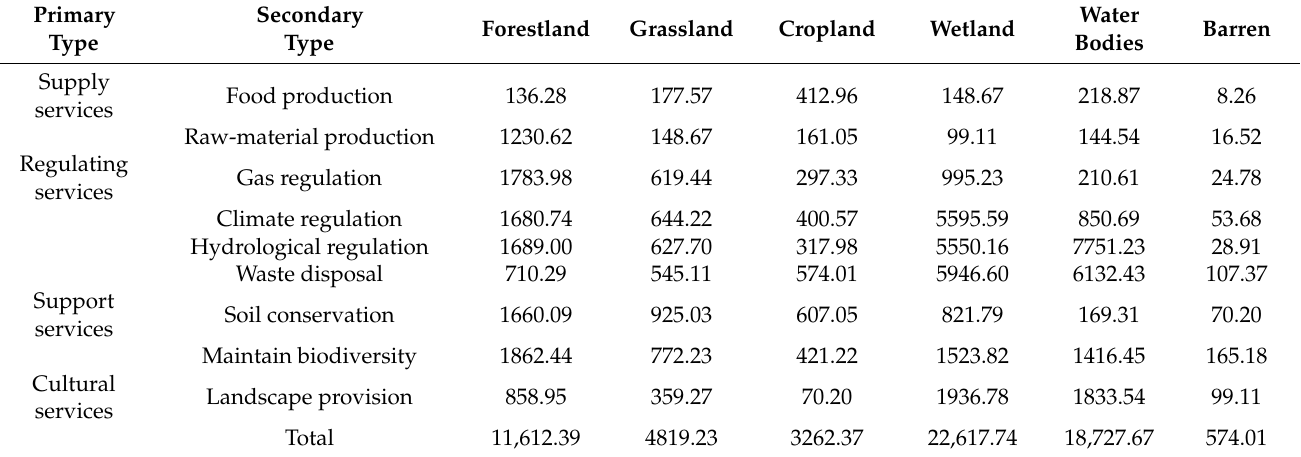
Table 2. The ecosystem service value (ESV) per unit area of different land types.